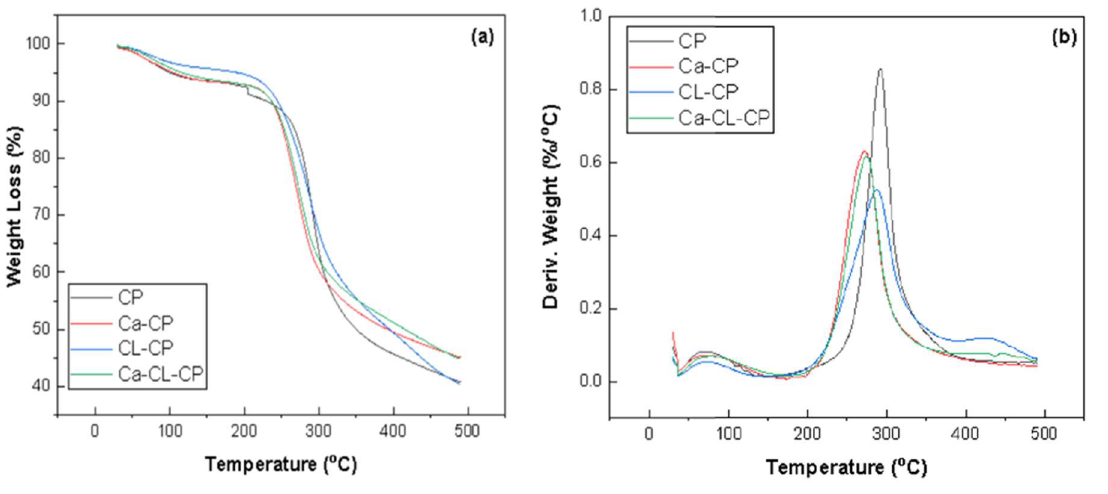
Figure 3. ( a ) Weight loss (%) and ( b ) differential thermal analysis (DTA) plots for CP, Ca–CP, CL–CP, and Ca–CL–CP.